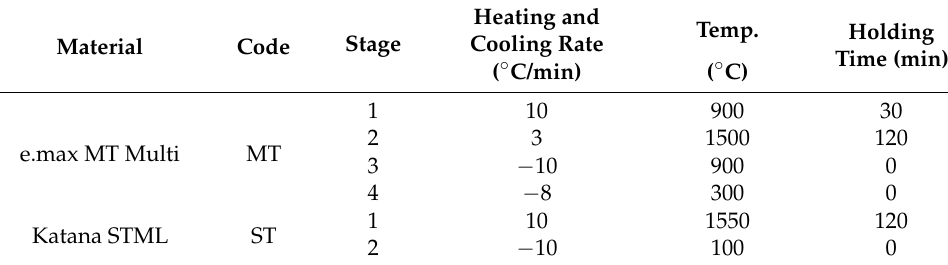
Table 2. Sintering protocols for the materials used. Material Code Stage